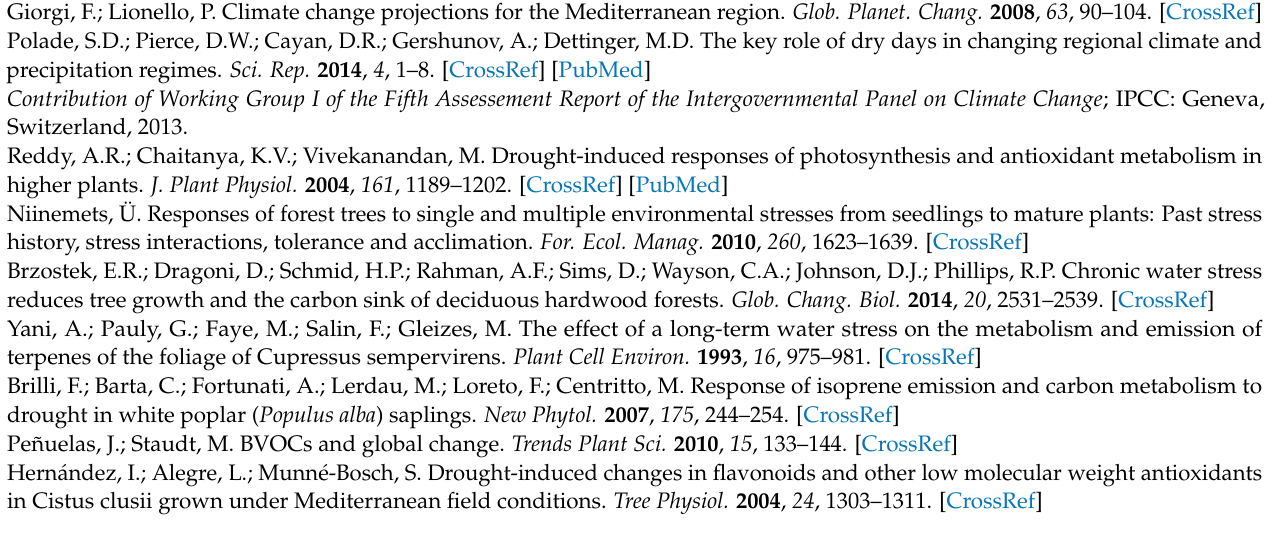
Table S3: Compound amounts (mg · g DM − 1 ) according to drought treatments and seasons in 2014 and 2015; Table S4: Pairwise comparisons performed after two-way PERMANOVA on metabolic finger- prints (untargeted analyses); Figure S1: Molecular network obtained through Global Natural Products Social molecular networking and visualized with Cytoscape; Figure S2: Principal Component Analy- sis (PCA) on metabolic fingerprints according to drought treatment and seasons in 2013 (left), 2014 (middle), and 2015 (right), Figure S3: Mass spectra of rhododendrin (commercial standard)